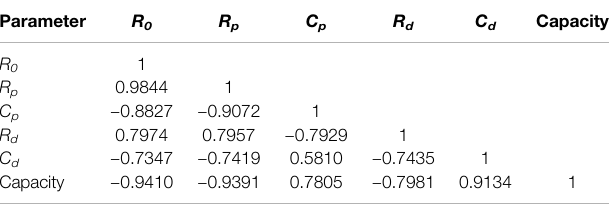
TABLE 3 | Correlation coef fi cient between parameters of Cell 1 (70%